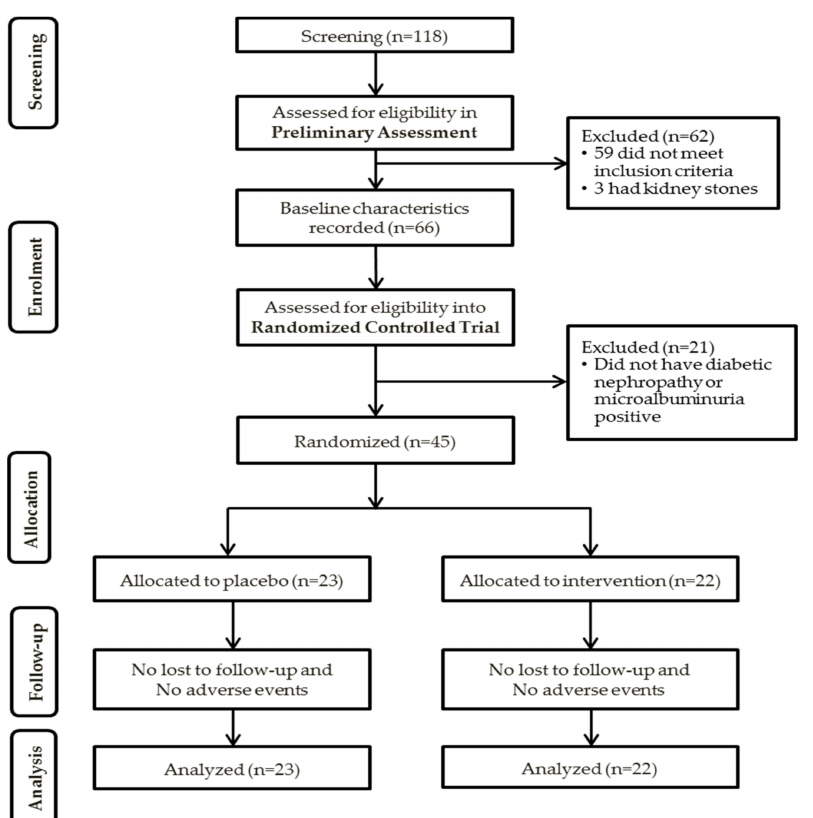
Figure 2. Summary of patient flow diagram. n: number of